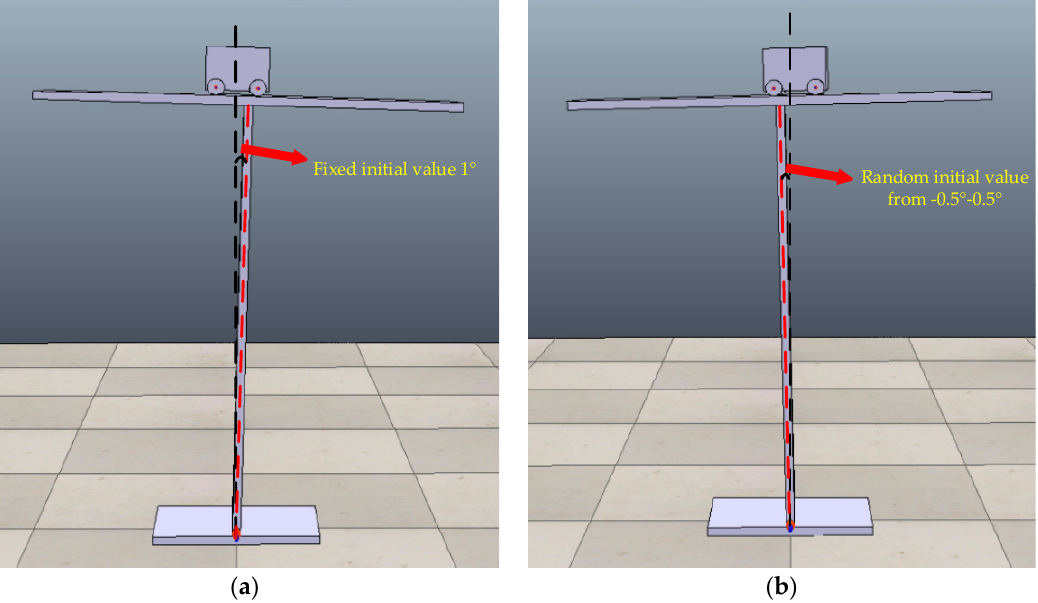
Figure 7. Two tasks in the evaluation of the proposed scheme. ( a ) Task 1: the initial angle between the leg of the table and the vertical direction is a fixed value of 1°. (The red dashed line is the table leg, and the black dashed line is the vertical direction.) ( b ) Task 2: the initial table angle is set as a random value between − 0.5° and 0.5° for each episode.